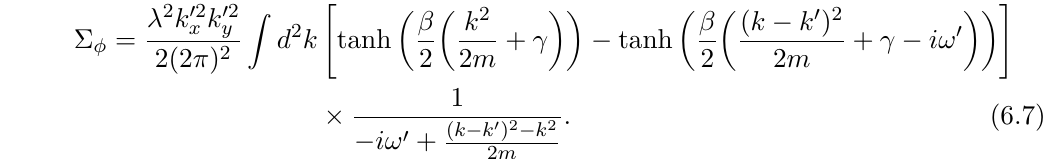
JHEP03(2023)115